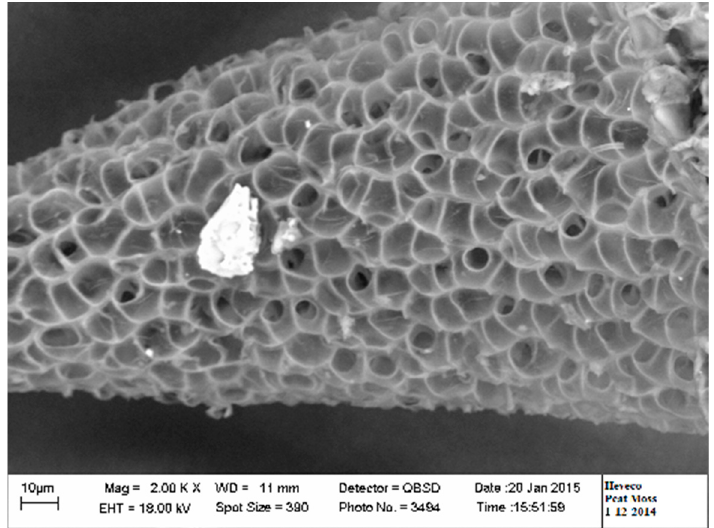
Figure 3. Scanning electron microscopic view of a peat moss particle. Sphagnum peat moss is usually mixed with other components to accentuate the physical characteristics of the growing media [33]. The incorporation of other components helps peat to maintain a good structure. Other reasons to incorporate other components are to increase aeration, to make the growing media less hydrophobic [36], to improve cation exchange capacity, to contribute to the nutrients charge, and to produce a drier mix. A component can be used alone or in combination with others. Table 3 lists the most common components used in peat-based growing media for growing medicinal cannabis. Table 3. Most common components used in combination with peat-based growing